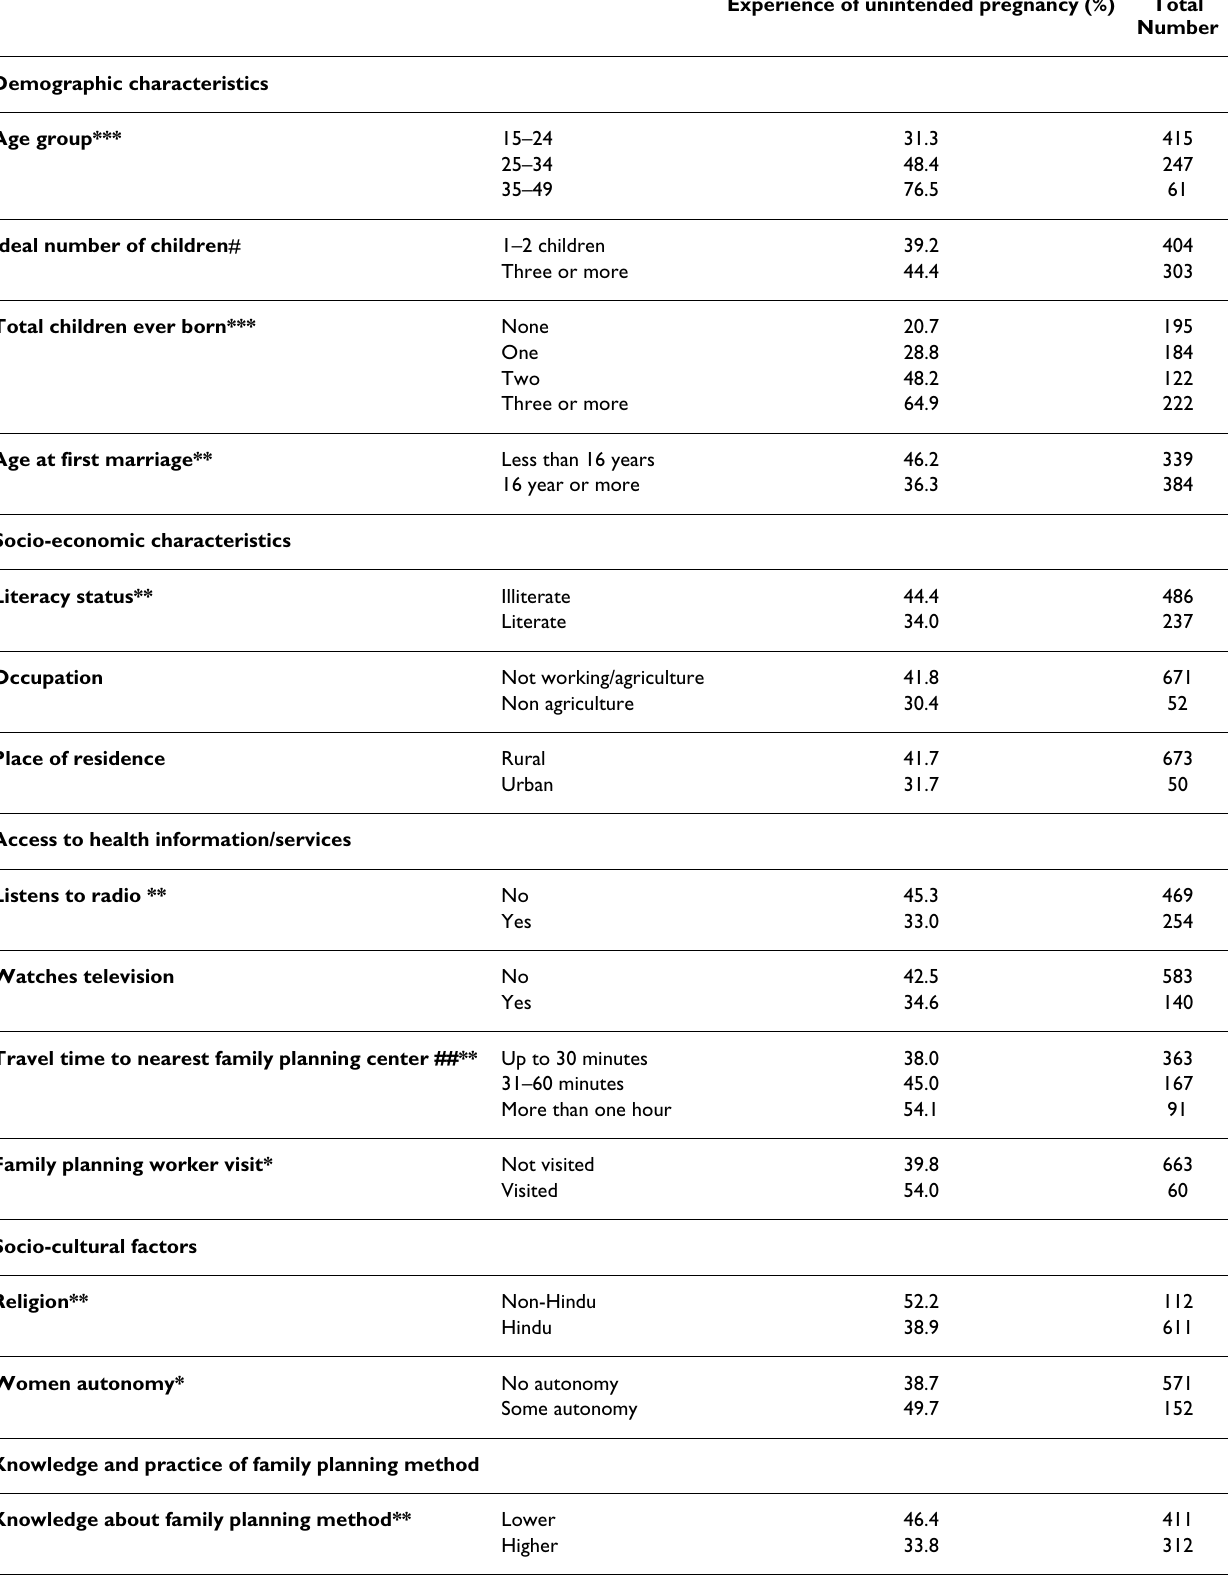
Experience of unintended pregnancy (%) Total